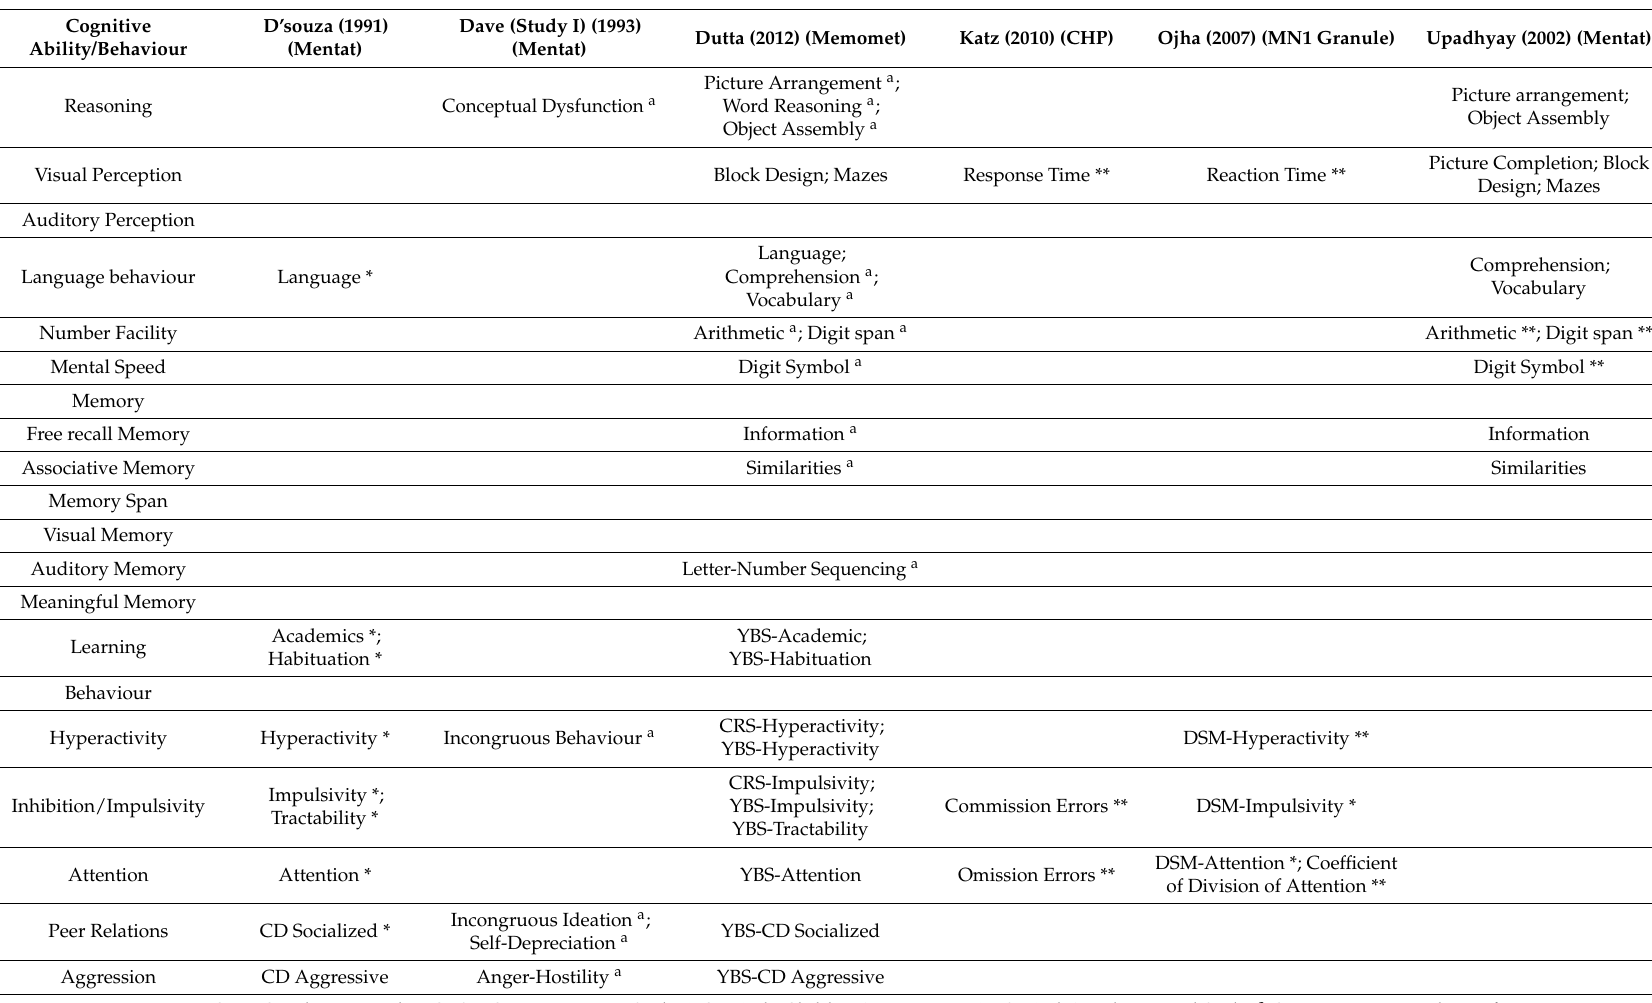
Table 3. True cognitive ability and behavioural construct